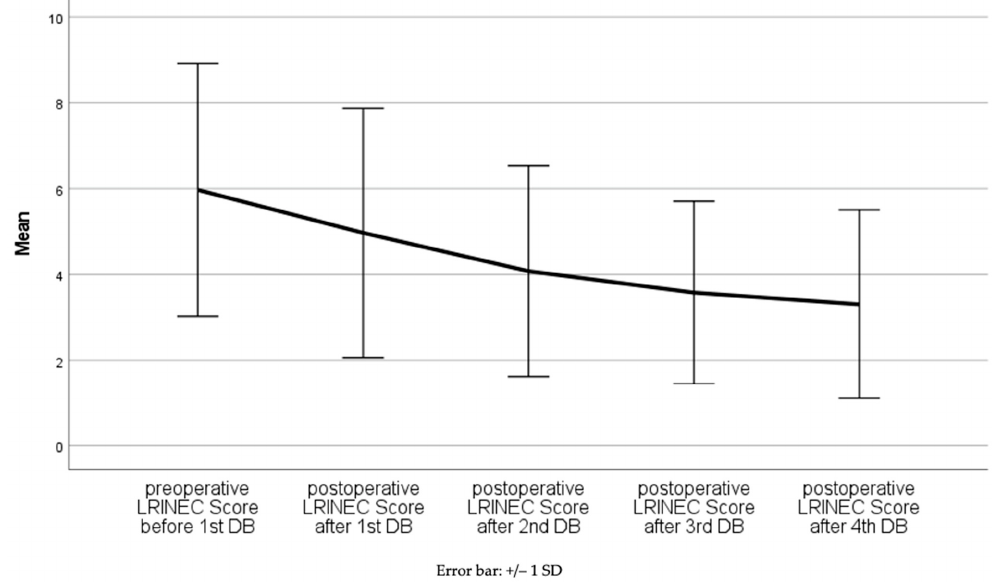
Figure 2. Mean LRINEC in the course of time